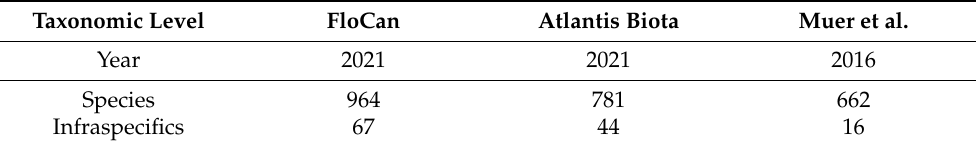
Table 3. Numbers of non-native species and non-native infraspecific taxa (subspecies, varieties) in current plant lists of the Canary Island